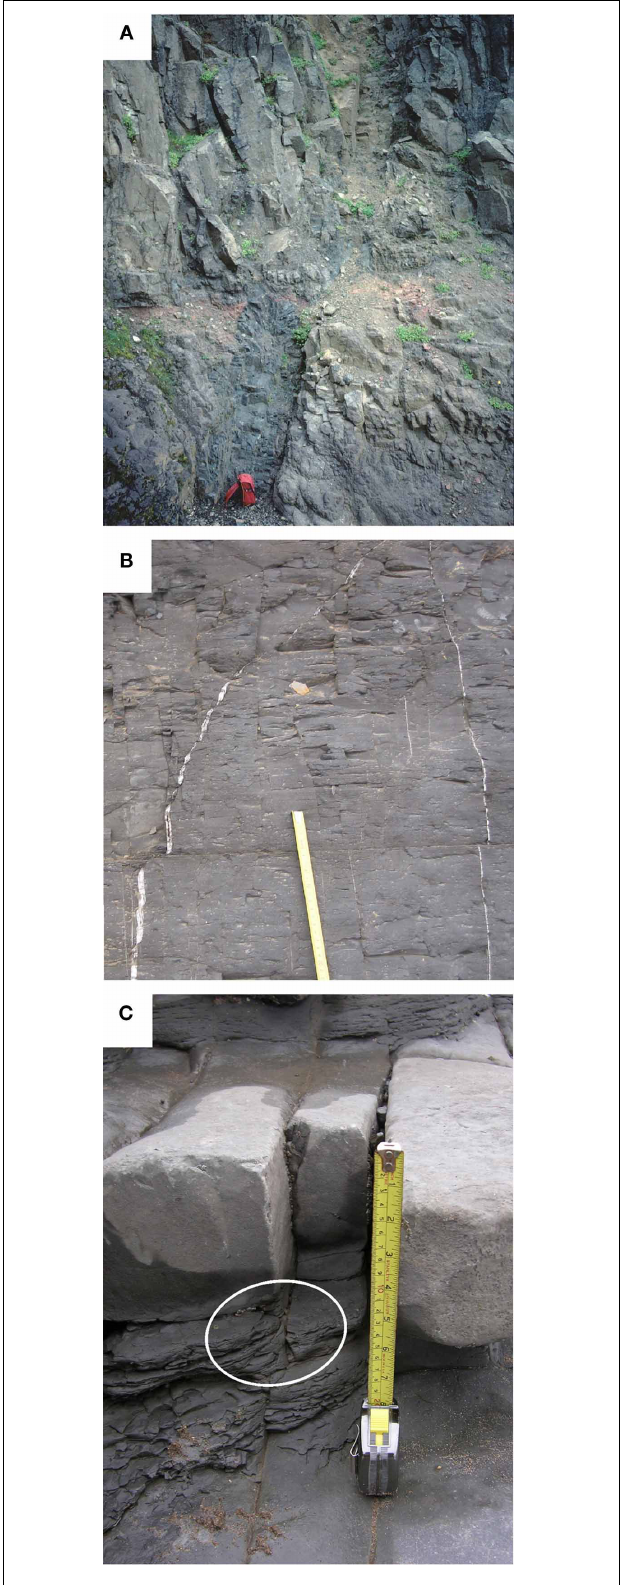
FIGURE 13 | Hydrofractures offset at contacts (cf. Brenner, 2003). (A) Dyke becomes offset on crossing a weak scoria contact between two basaltic lava flows in the paleorift zone of North Iceland. View north; the backpack at the lower dyke segment provides a scale. (B) Calcite veins offset at a weak contact between shale layers at Kilve, Somerset coast, Southwest England. View south; the visible part of the measuring steel tape is 0.3m long. (C) Joint (encircled) becomes offset at a weak contact between shale layers at Nash Point, Glamorgan coast, South Wales. View south; the measuring steel tape is 0.2m